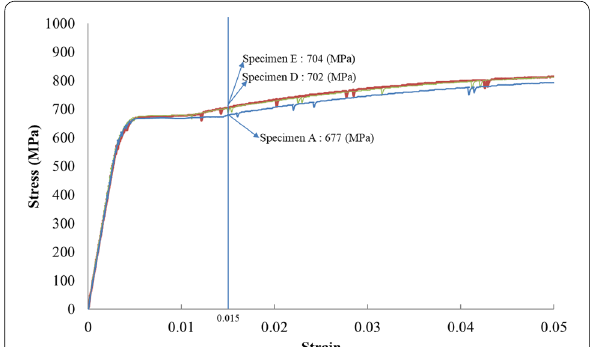
Fig. 10 Tensile stress–strain relationship of the flexural re‑bars in Specimens A, D, and